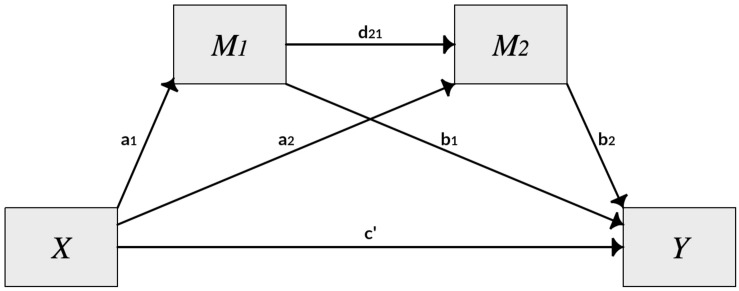
Statistical diagram of model 6 of the PROCESS macro, based on Hayes (2018).